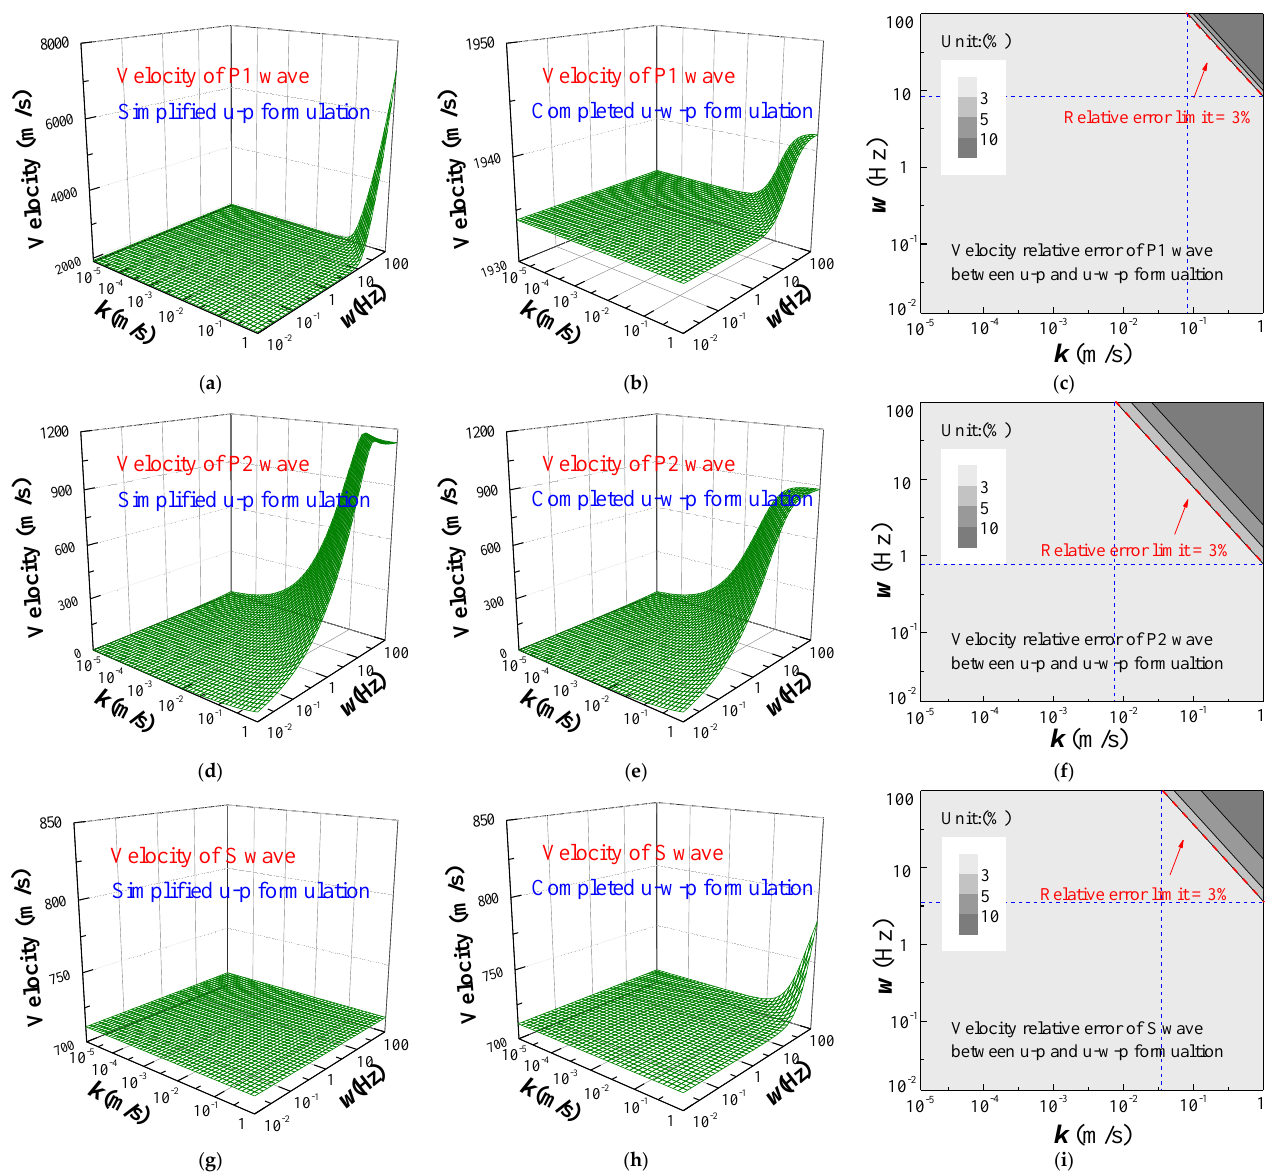
Figure 4. Velocities obtained from u - p and u - w - p formulations and relative errors of velocities in saturated gravel soil.